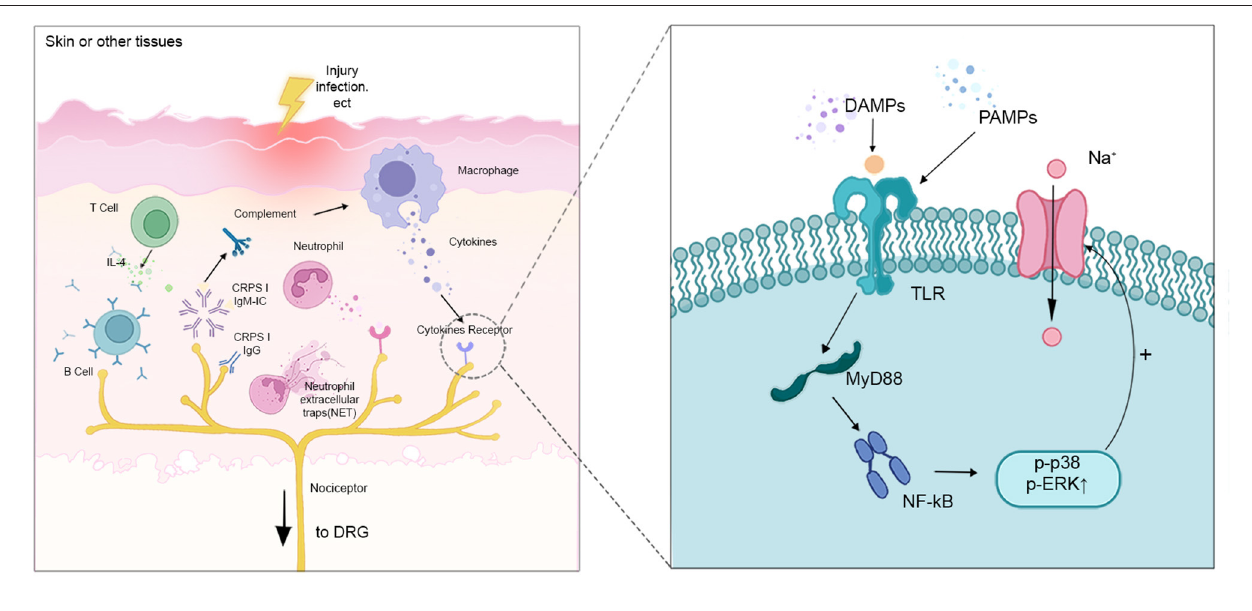
FIGURE 2 | Interactions between the distal part of nociceptors with different immune cells. When injury and infection happen, macrophages are induced to produce DAMP and PAMP. They activate TLRs expressed in nociceptive neurons and up-regulate the expression of MyD88, which promotes the MAPK signaling pathway through NF- κ B. MyD88 also activates sodium channels in sensory neurons, increasing the excitability of the nociceptors. T cells release IL-4 to activate B cells, which produce CRPSI IgM and IgG. CRPS IgM, binding to the corresponding neoantigens. The antigen-IgM complex promotes complements (e.g., C5a), leading to increased expression of pro-inflammatory cytokines and peripheral